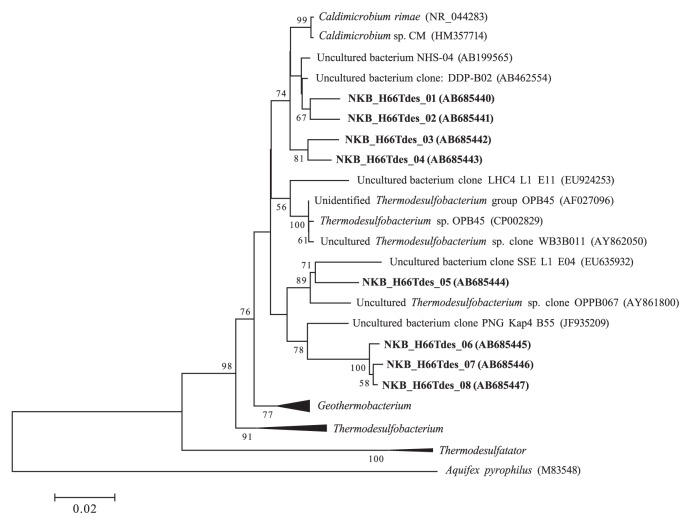
Neighbor-joining phylogenetic tree of the phylum Thermodesulfobacteria based on 16S rRNA gene sequences (E. coli positions 160–845). Clones from this study are in bold. Accession numbers are shown in parentheses. Bootstrap support values >50% are given. Scale bar shows 2% estimated sequence divergence.